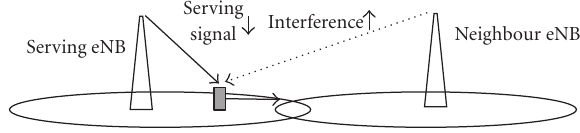
Figure 2: Illustration of UE moving away from the serving